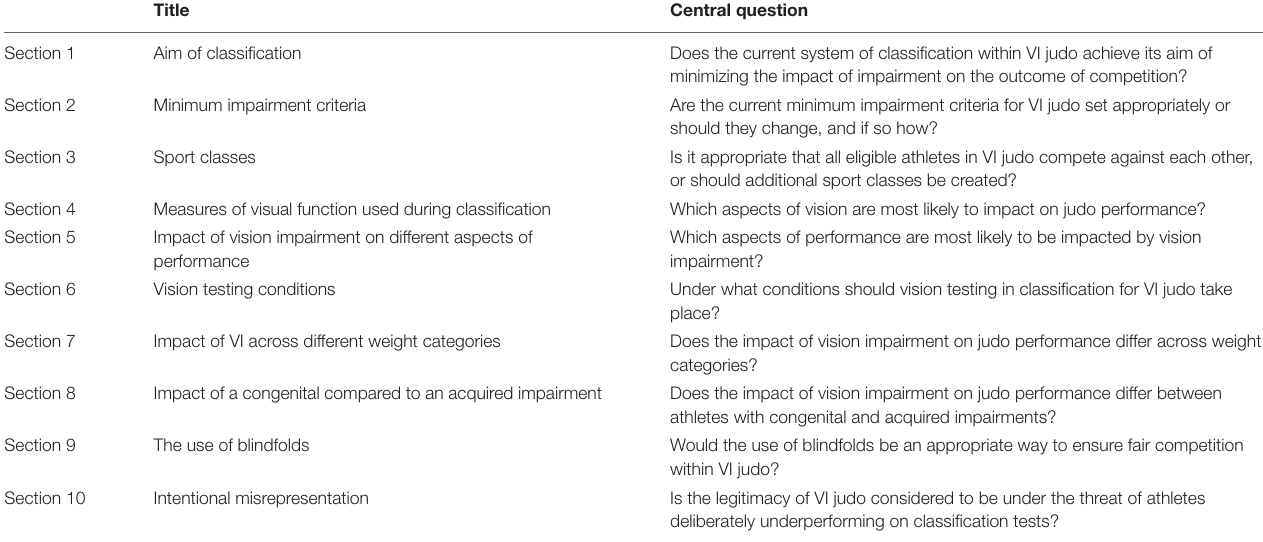
TABLE 2 | Description of the 10 different sections covered throughout the surveys, along with the central question each section aimed to